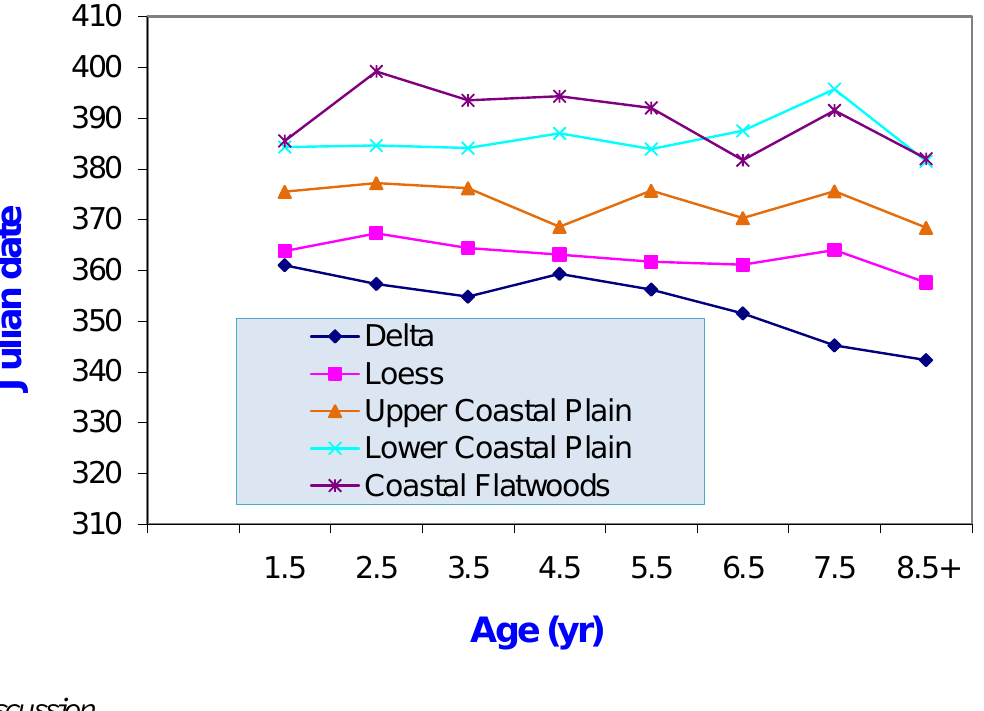
Figure 4. Conception dates for white-tailed deer by soils in Mississippi herd health study during March 1991 –